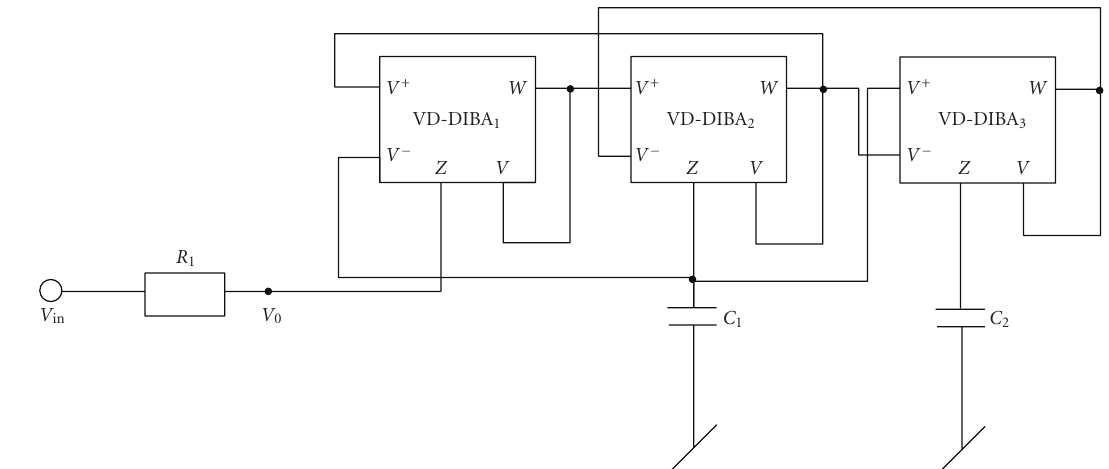
Figure 7: BRF realized by the new floating simulated inductor.